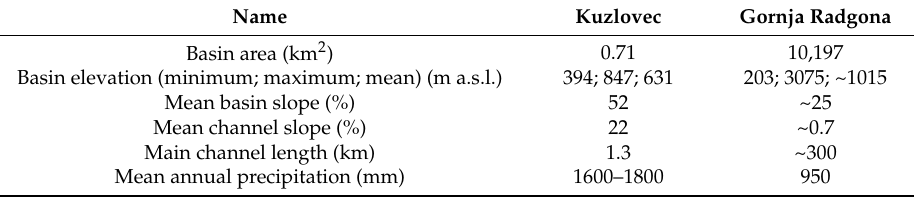
Figure 1. Location of the Gradašˇcica River basin and Gornja Radgona station on the topographic map of Slovenia with the main stream network. Table 1. Basic characteristics of the Kuzlovec torrent and Gornja Radgona station on the Mura River.